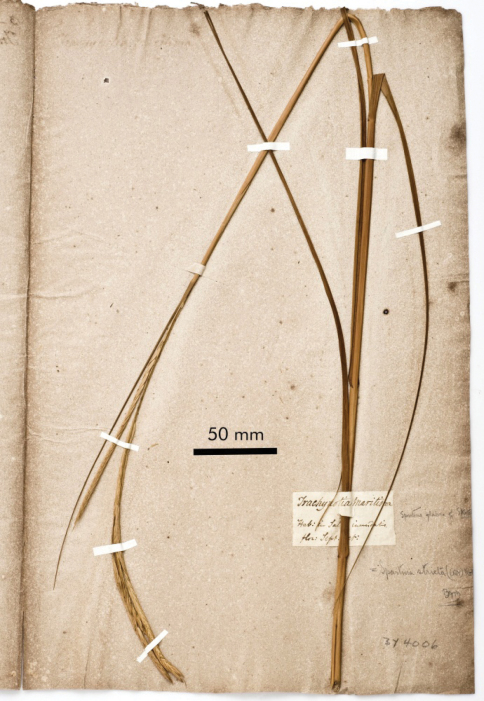
Holotype specimen of Spartina glabra (Elliott s.n., ChMBY4006). Photo: Sean Money, Charleston Museum.